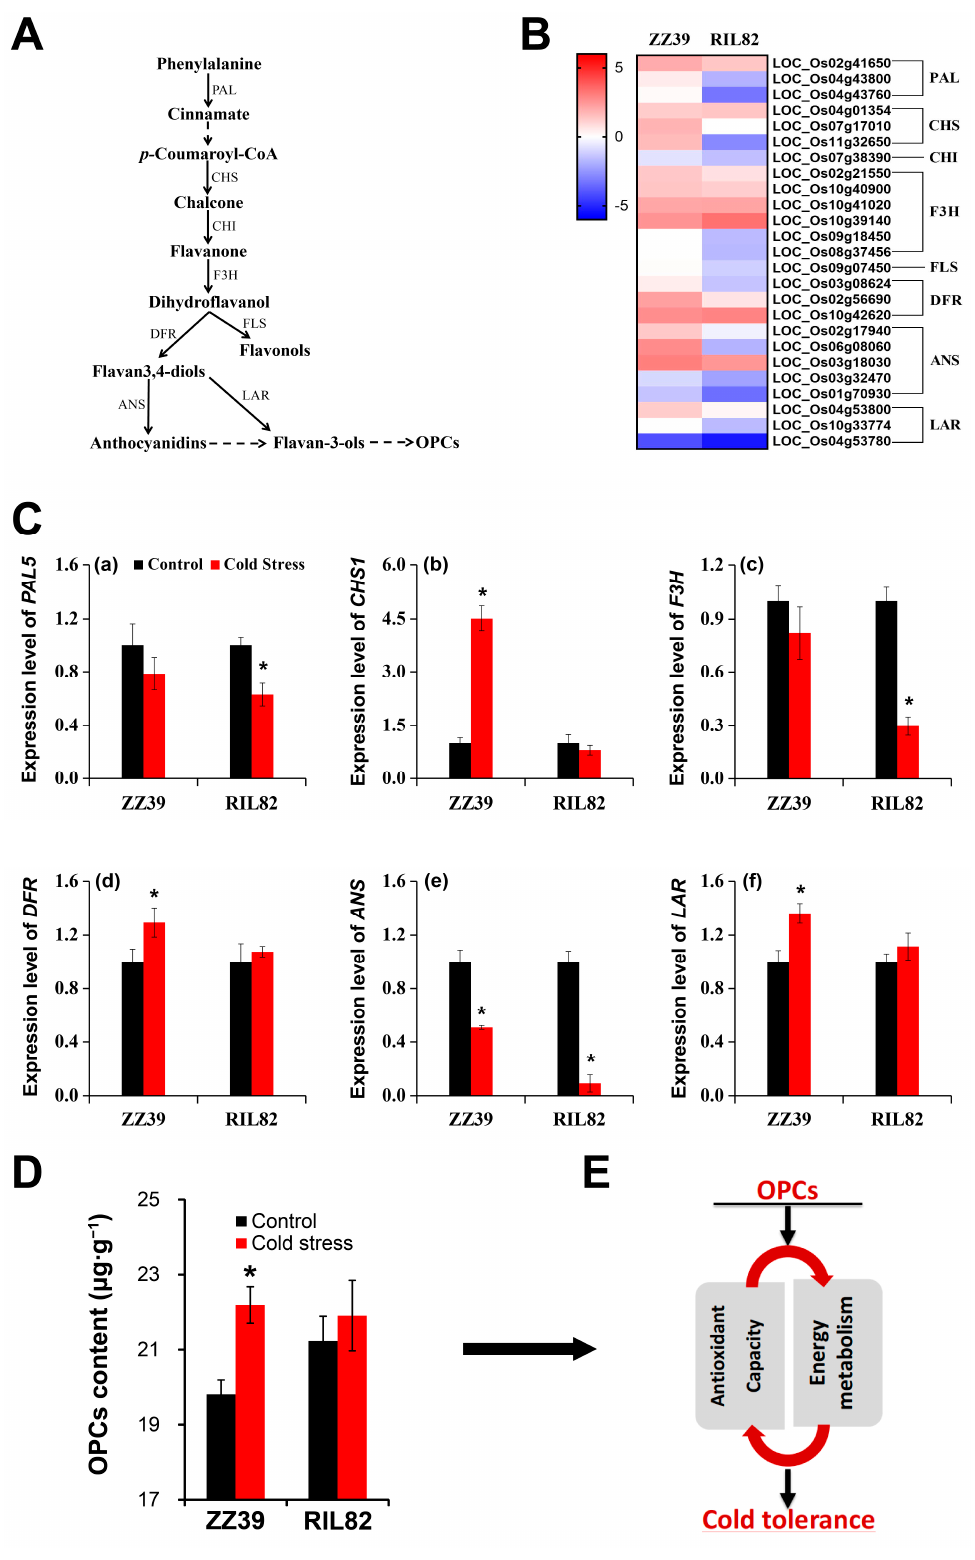
Figure 3. Transcriptome analysis on OPCs pathway in rice seedling plants under cold stress. ( A ), a schematic diagram on the synthesis OPCs; ( B ), heat map of enzyme genes involved in OPC synthesis (log 2 |FoldChange|); ( C ), Relative expression of enzyme genes involved in OPC synthesis; ( D ), OPC contents; ( E ), descriptive model of the relationships between OPCs, the antioxidant system, and energy homeostasis in plants under cold stress. OPCs, oligomeric proanthocyanidins. * denotes p <